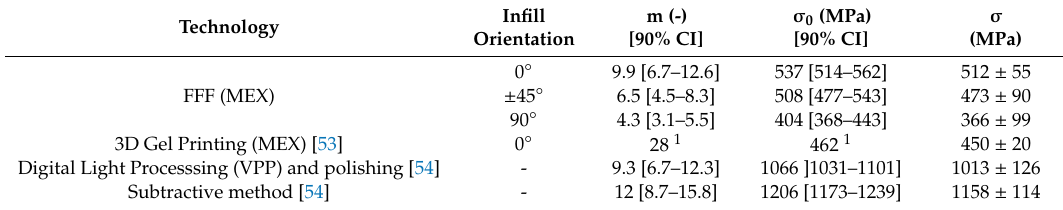
Figure 9. ( a ) Schematics of the bending tests for specimens produced with the three infill orientations; ( b ) Weibull plot of the specimens produced with the different infill orientations. Table 2. Weibull modulus (m), characteristic bending strength ( σ 0 ) and average bending strength ( σ ) of the specimens produced with the three infill orientations. For comparison, 3 mol % yttria-stabilized tetragonal zirconia parts produced by additive manufacturing material extrusion (MEX), vat photopolymerization (VPP) and subtractive methods are shown. A 90% confidence intervals are given in square brackets.